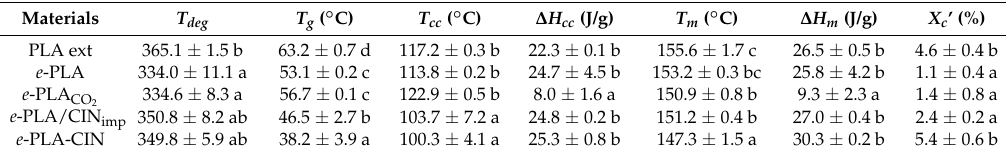
Table 3. Thermal properties of e -PLA-based mats.